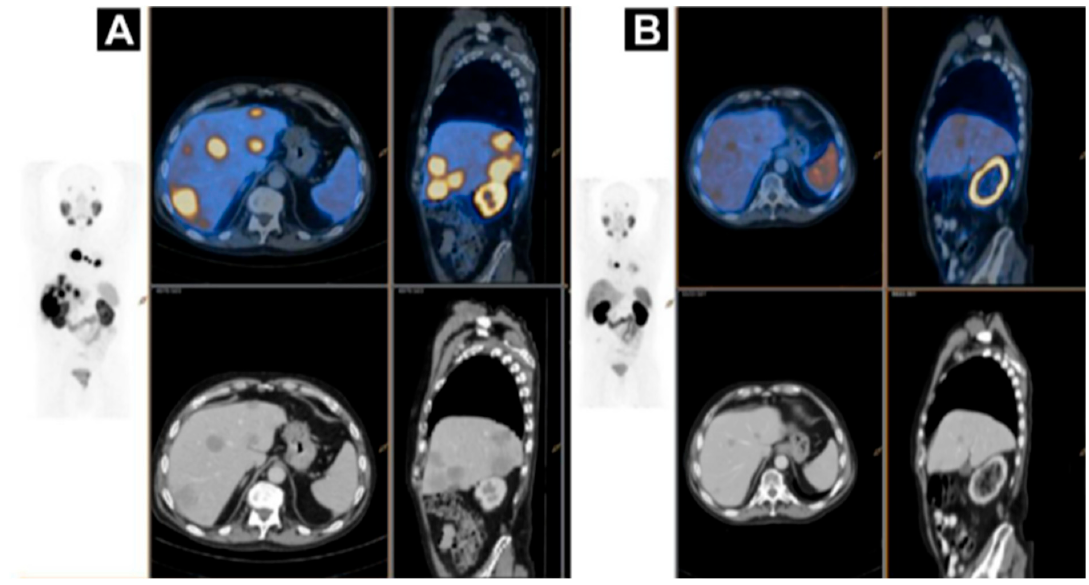
Figure 8. A case of homogenous treatment response ( A ) [ 68 Ga]Ga-HBEDD PSMA-11/PET-CT: Highly PSMA-avid liver and mediastinal lymph nodal metastases (SUVmax 70) on screening (PSA 340 ng/mL). ( B ) [ 68 Ga]Ga-HBEDD PSMA-11/PET-CT: 3 months after 4 cycles of [ 177 Lu]Lu-PSMA therapy (PSA 1.5 ng/mL) exhibited marked biomarker and RECIST response with minimal residual PSMA activity in liver metastases and solitary PSMA-avid mediastinal lymph node. Reproduced from [146].